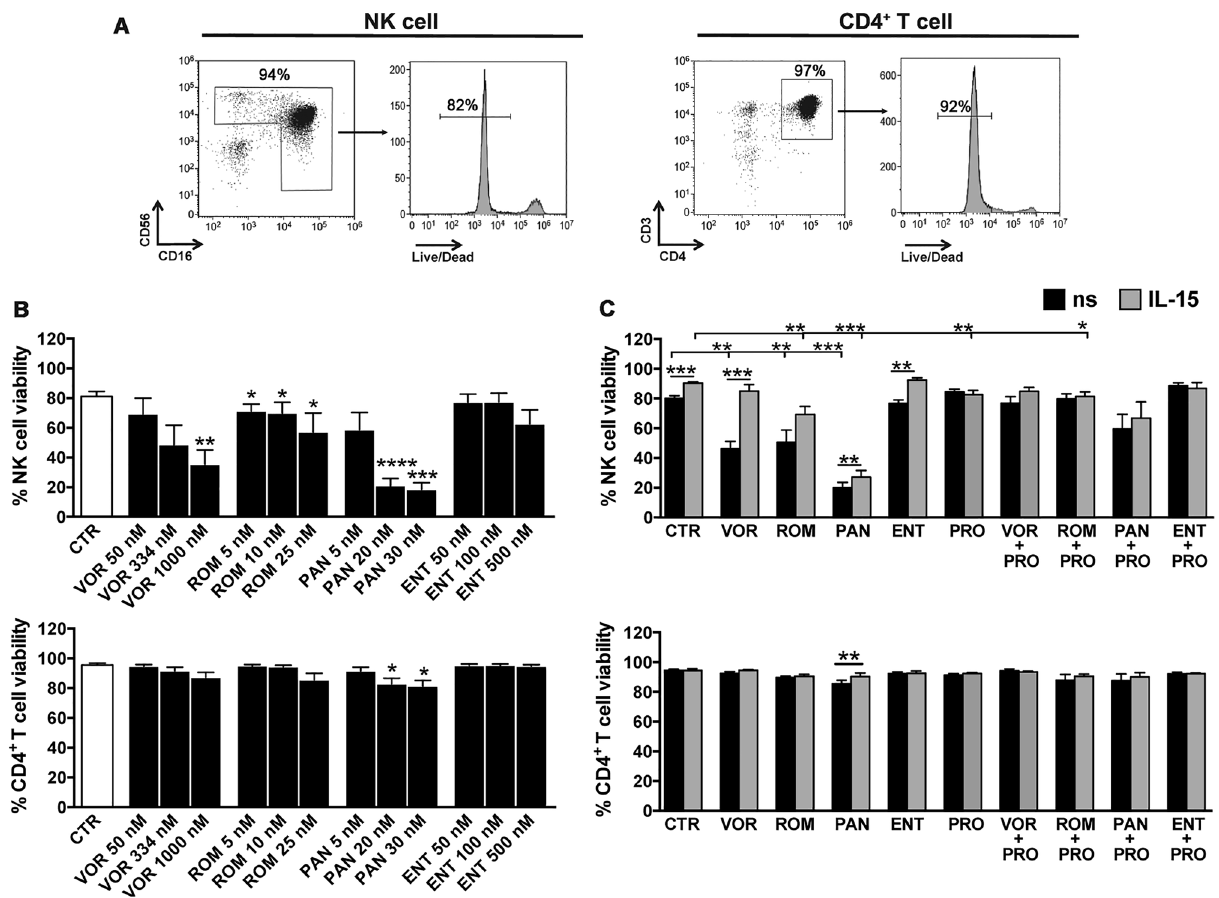
Figure 1. Effect of IL-15/LRA combinations on NK and CD4 + T cell viability . NK and CD4 + T cells purified from PBMCs of healthy donors were cultivated for 72 h without stimuli or in the presence of single or combined LRAs, then cell viability was examined by LIVE/DEAD staining. Cell viability was examined after 72 h by LIVE/DEAD staining. ( A ) Percentage of live purified NK and CD4 + T cells of representative unstimulated cell cultures from one donor. ( B ) NK and CD4 + T cells were untreated (control, CTR) or stimulated with different doses of VOR (50, 334, 1000 nM), ROM (5, 10, 25 nM), PAN (5, 20, 30 nM) or ENT (50, 100, 500 nM). Bars represent mean ± SEM obtained from 4 independent donors. Statistics was performed using paired test versus unstimulated control. ( C ) NK and CD4 + T cells were cultivated without stimuli (CTR), in the presence of 334 nM VOR, 20 nM PAN, 10 nM ROM, 100 nM ENT, 1 µM PRO alone or in HDACi + PRO combinations, all condition including or not 12.5 ng/ml of IL-15. Bars represent mean ± SEM obtained from at least 4 independent donors. Statistics was performed using paired Wilcoxon or t -test for non-parametric and parametric distributions, respectively. * p < 0.05; ** p < 0.01; *** p < 0.001; **** p < added to VOR, ROM or ENT, with an increase in the expression of NKG2D, NKp30 and NKp44 as compared to HDACi alone or CTR, but CD16 expression (down-modulated by PRO) was decreased. Overall, the stimulatory effects of PRO and IL-15 on NK cell activating receptors was largely maintained when used in association with any HDACi with the exception of the PAN + IL-15 combination in which the PAN-mediated downregulation of various receptors persisted. By combining IL-15 with PRO, NKp44 but not NKG2D and NKp30, was further up-modulated as compared with single treatments, whereas both NKp46 and CD16 were reduced in comparison with IL-15 or PRO alone as well as CTR. Finally, the addition of IL-15 had minor effects on receptor modulation in HDACi + PRO combinations, with the exception of NKp30 that was up-regulated to higher levels, comparable to those observed with IL-15 alone. To assess their cytotoxic activity after 72 h of treatment, NK cells were challenged for 4 h with K562 cells, an erythroleukemia cell line that expresses ligands for several activating receptors (NKG2D, DNAM-1, NKp30, NKp44, NKp46) and is devoid of HLA-I ligands for inhibitory receptors 42 , hence functioning as a highly suscepti- ble target of NK cell cytotoxicity. Figure 3 shows that in most donors pan-HDACi but not ENT impaired cytotox- icity as compared with CTR. In addition, treatment with PRO had no particular effect and, when combined with any HDACi other than ENT, a trend towards inhibition was observed. As expected, exposure to IL-15 boosted cytotoxicity of NK cells in all tested donors, a positive effect that was generally maintained in IL-15 + HDACi combinations with the exception of PAN + IL-15 by which NK-cell function was strongly impaired as in the single PAN condition. Combining IL-15 with PRO had a donor-to-donor variable effect but overall did not significantly change the IL-15-mediated increase of cytotoxicity. Finally, treatment with the triple HDACi + PRO + IL-15